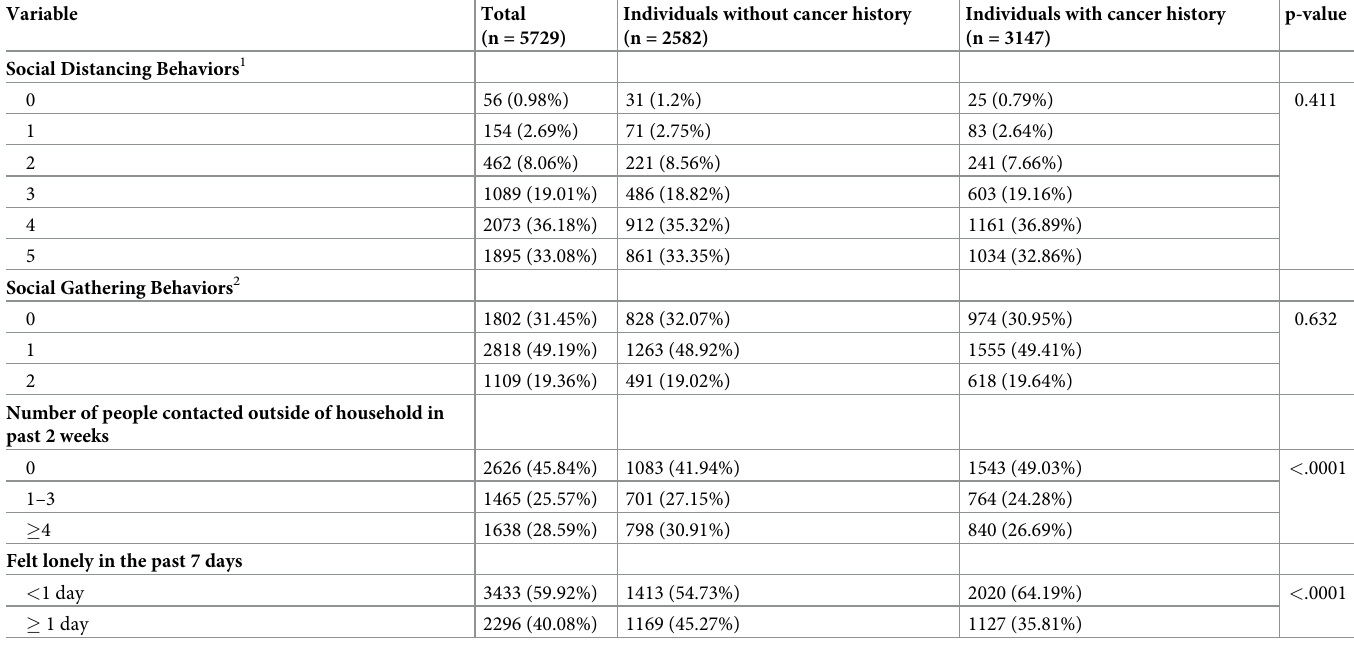
Table 2. Social distancing measures of adults during the COVID-19 pandemic stratified by cancer history.